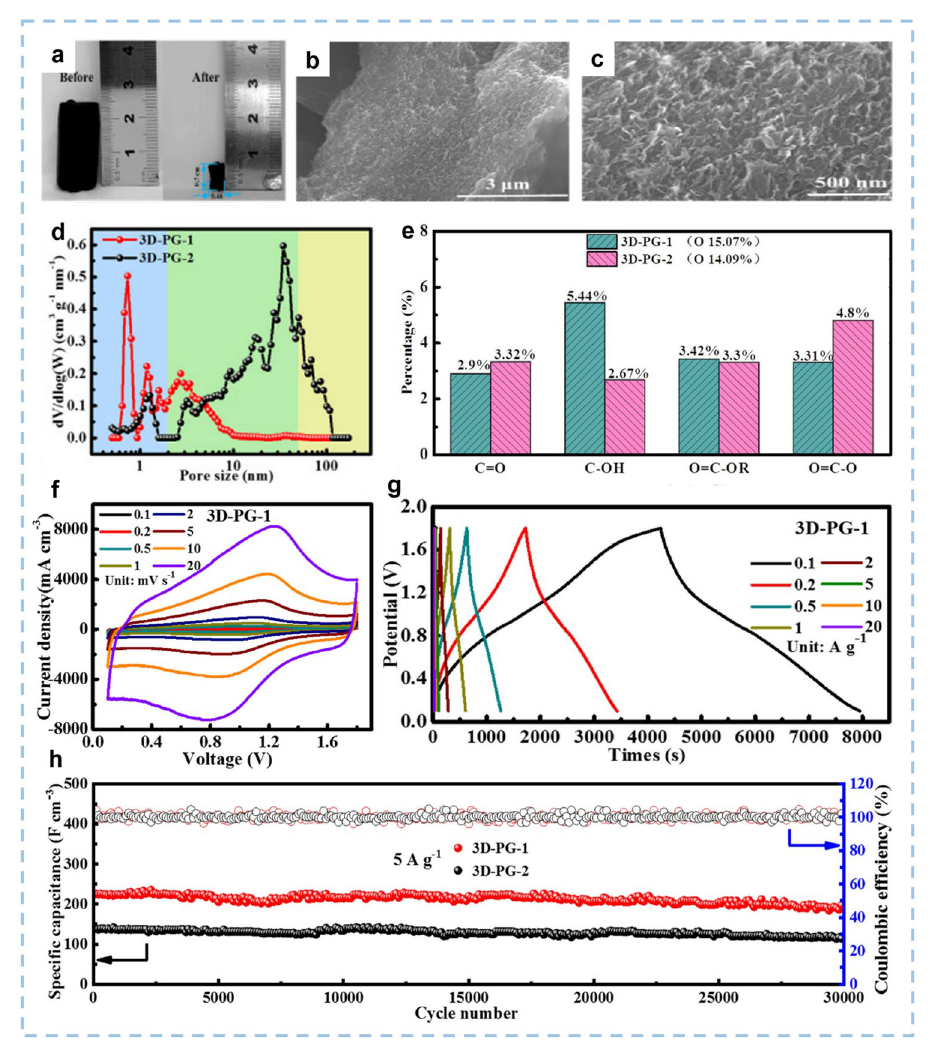
Fig. 11 The photograph, microstructure, pore size, and the electrochemical performance of the 3D-PG-1 cathode. a The photograph of 3D-PG-1 (before and after different drying methods), b and SEM images of 3D-PG-1. c Magnified SEM images of 3D-PG-1. d Pore size distri- bution of 3D-PG-1 and 3D-PG-2 (the blue area is micropore, green is mesopore, and yellow is macropore). e The proportion of different oxygen- containing functional groups in 3D-PG-1 and 3D-PG-2. f CV curves at different scan rates. g GCD curves at different current densities. h Long cycling stability at 5 A g −1 . Reproduced with permission [177]. Copyright 2022,